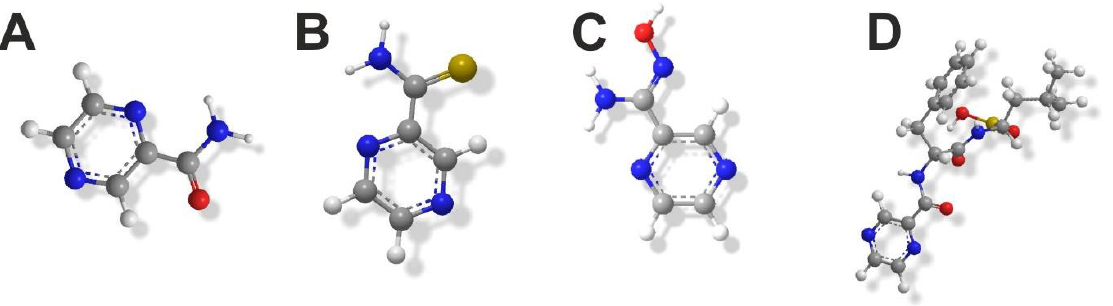
Figure 1. Analyzed structures of PZA as an antituberculosis drug ( A ); PTCA ( B ) and PAOX ( C ) as antifungals; BZM as an anticancer drug ( D ).